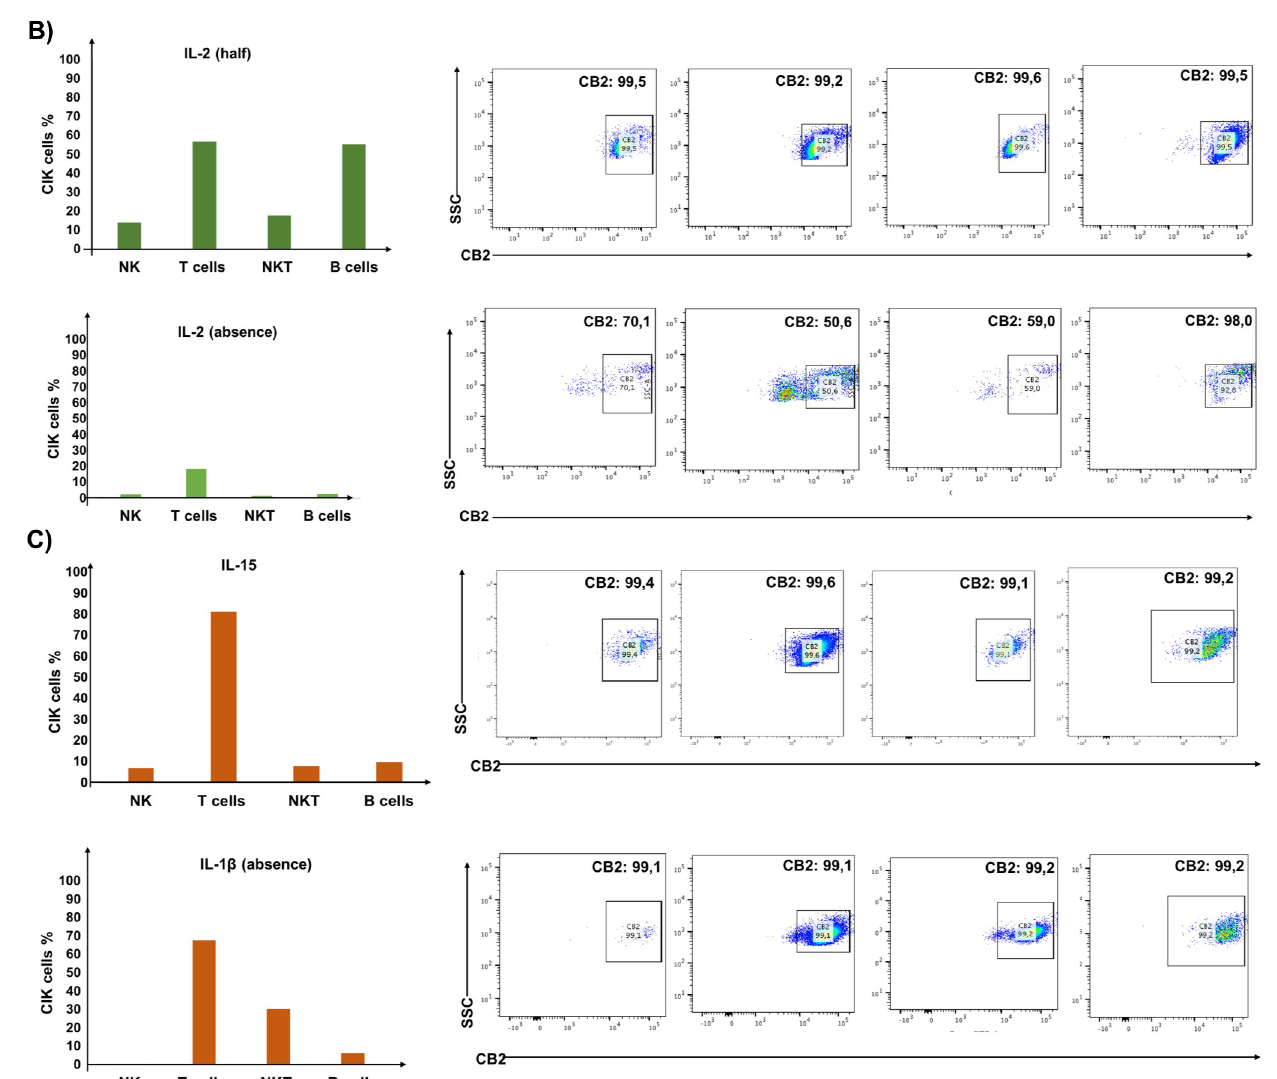
Figure 1. Differential expression of CB2 receptor in the cell subsets of CIK cells. CIK cells were cultured ( A ) in the absence of anti–CD3 antibody ( upper panel) and IFN– γ ( lower panel), ( B ) in half of the amount of IL–2 ( upper panel) and in the absence of IL–2 ( lower panel), and ( C ) with IL–15 ( upper panel) and in the absence of IL–1 β ( lower panel). In all experiments, CIK cells were immunophenotyped at day 14 by flow cytometry and the differential expression of CB2 receptor in the main cell subsets of human CIK cells, i.e., NKT, T, NK, and B cells were